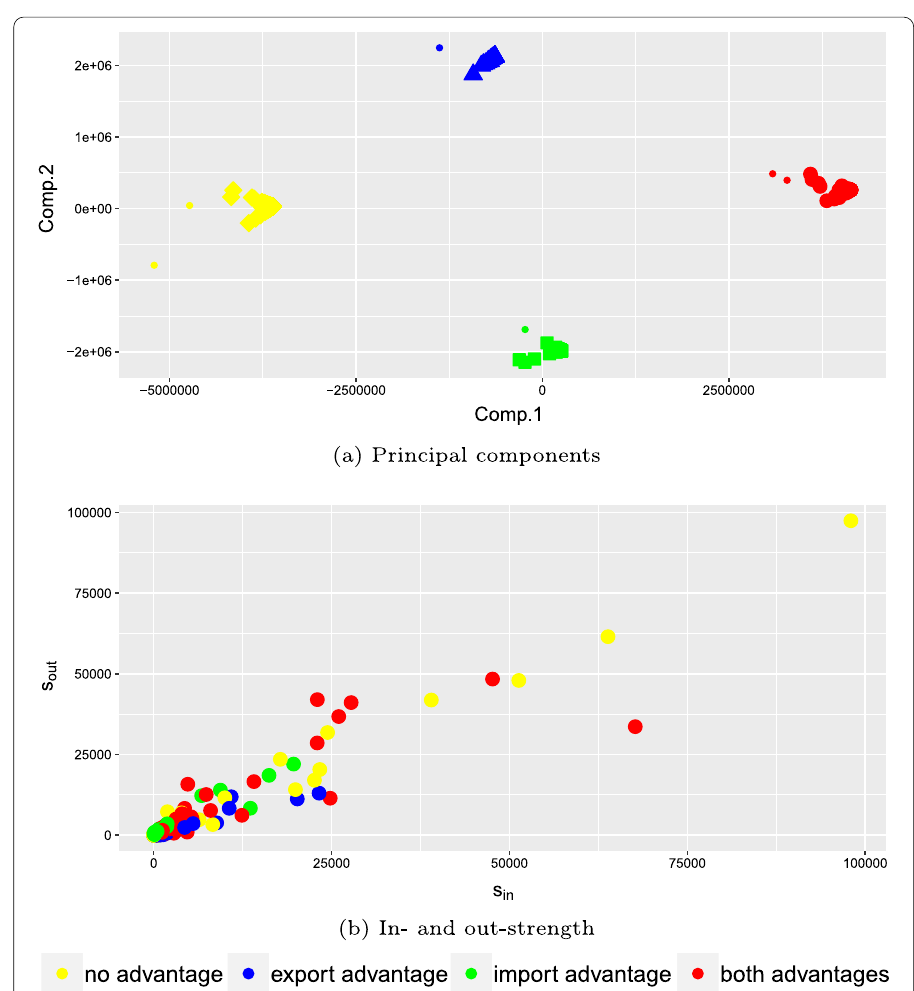
Fig. 10 Above: For the Transportation services (S205) network in year 2012, the Principal Component Analysis of the Directed Graphlet Degree Vectors perfectly classifies the countries’ role in terms of their import/export Relative Comparative Advantage. Below: The classification fails if only in-/out-strenght (i.e. import/export flows) are